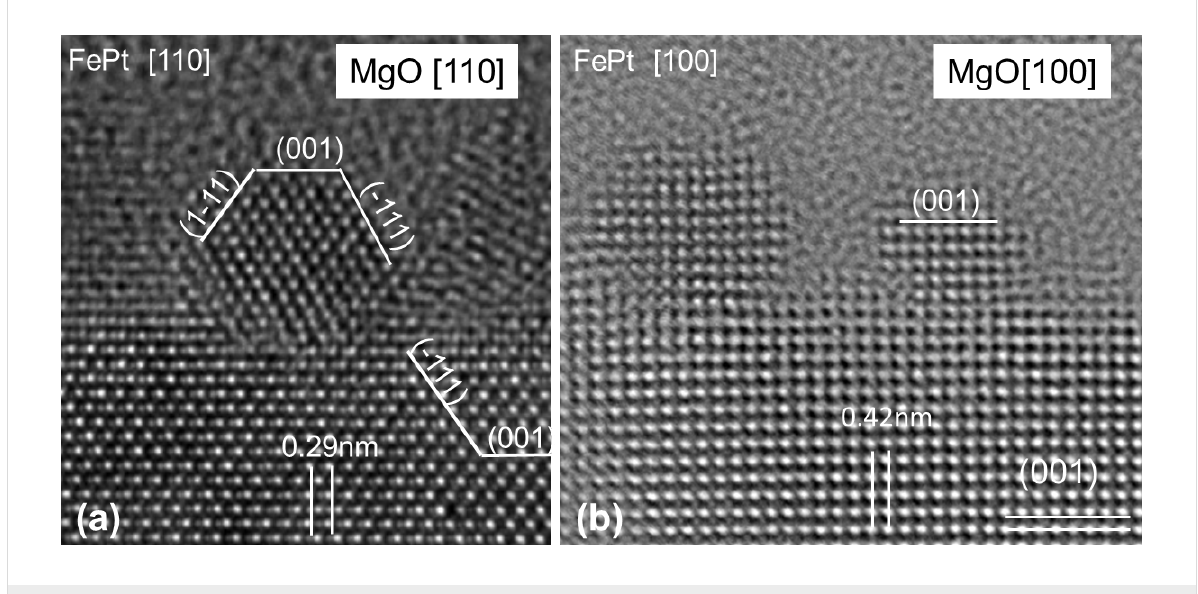
Figure 1: Cross-section HRTEM images of small (2–3 nm) FePt NPs on a MgO(001) substrate after annealing at 650 °C for 30 min: viewed in (a) [110] and (b) [100] direction. In the lower part the MgO substrate with indexed lattice planes is visible and used for calibration. The three FePt NPs in (a) and (b) show clear facets at the surface. The orientation of these small NPs can easily be determined as cube-on-cube epitaxy with FePt(001) || MgO(001) and FePt[100] ||